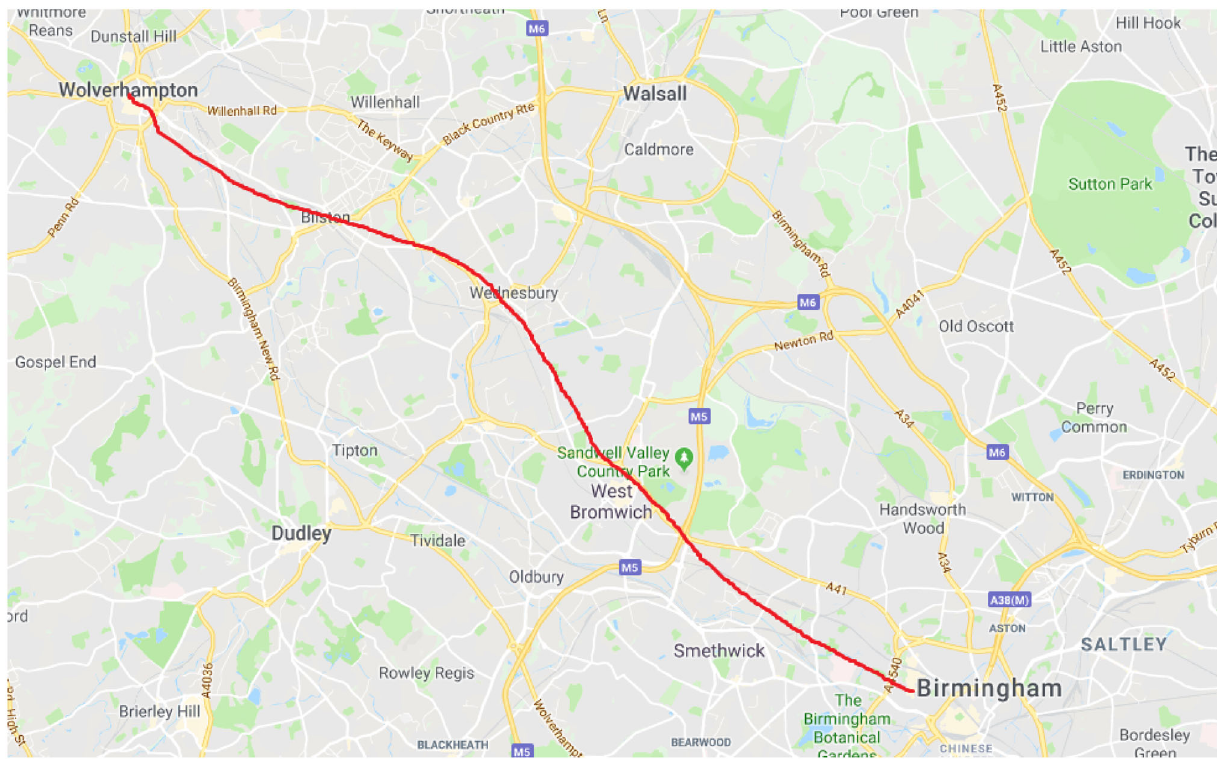
Fig. 1 Geographical overview of West Midlands Metro line